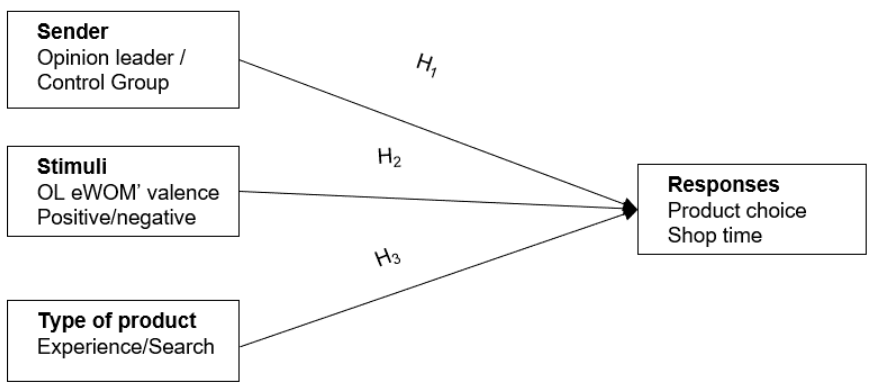
Figure 1. Research